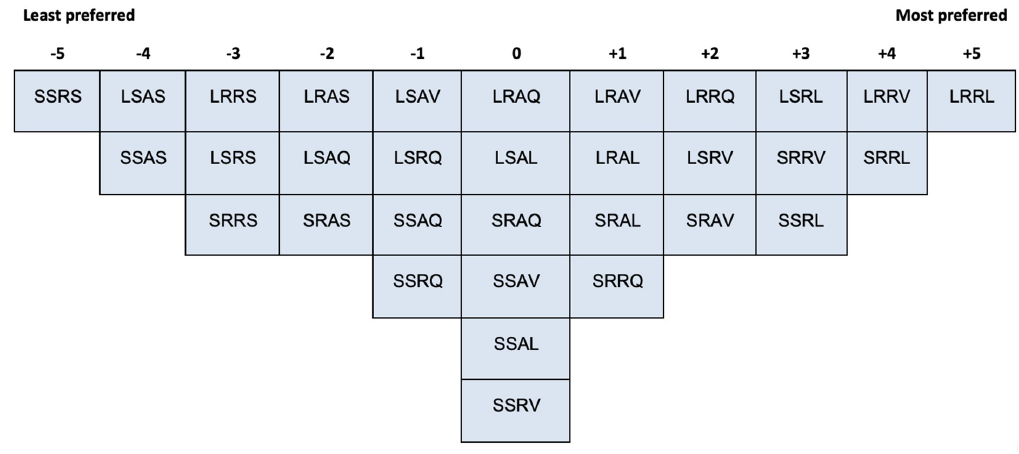
Figure 9. The shared Q-sorting result of participants loaded on Q-factor 3. As for participants loaded on Q-factor 3, they ranked quiescent objects as the least preferred because “ they are just boring ” (P11). They liked vibrating IOs the most, just as participant P12 indicated “ I prefer vibration to everything else. It’s like massage ”. While participants loaded on Q-factor 1 and 2 ranked sounding IOs as the least preferred, participants loaded on Q-factor 3 preferred sounding IOs to quiescent ones. Participant P17 explained that “ I never heard a ball making a sound, it’s quite cool ”. To further explore which variable(s) each cluster of participants paid more attention to, the dominance weights of variables were calculated separately for each cluster of participants (see Table 2). By inspecting these weights, we can infer that: Participants who were significantly loaded on Q- factor 1 mainly based their aesthetic judgement on the behaviour and the surface texture; participants loaded on Q-factor 2 mainly considered the behaviour, but still paid certain attention to the surface texture and contour; and participants loaded on Q-factor 3 mainly focused on the behaviour with